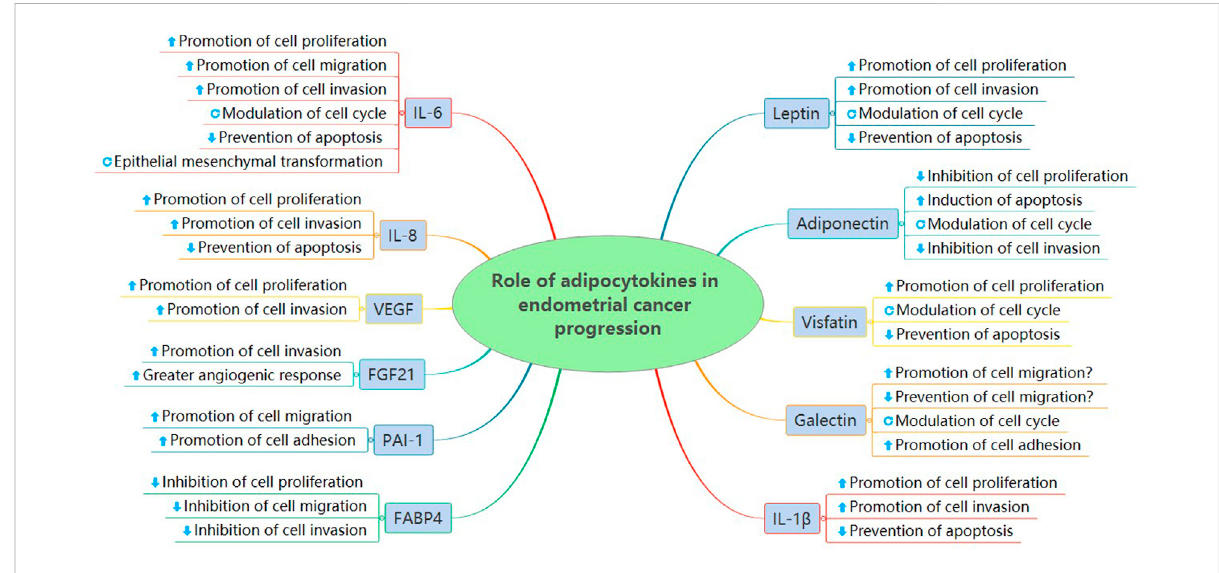
FIGURE 4 Role of adipocytokines in endometrial cancer